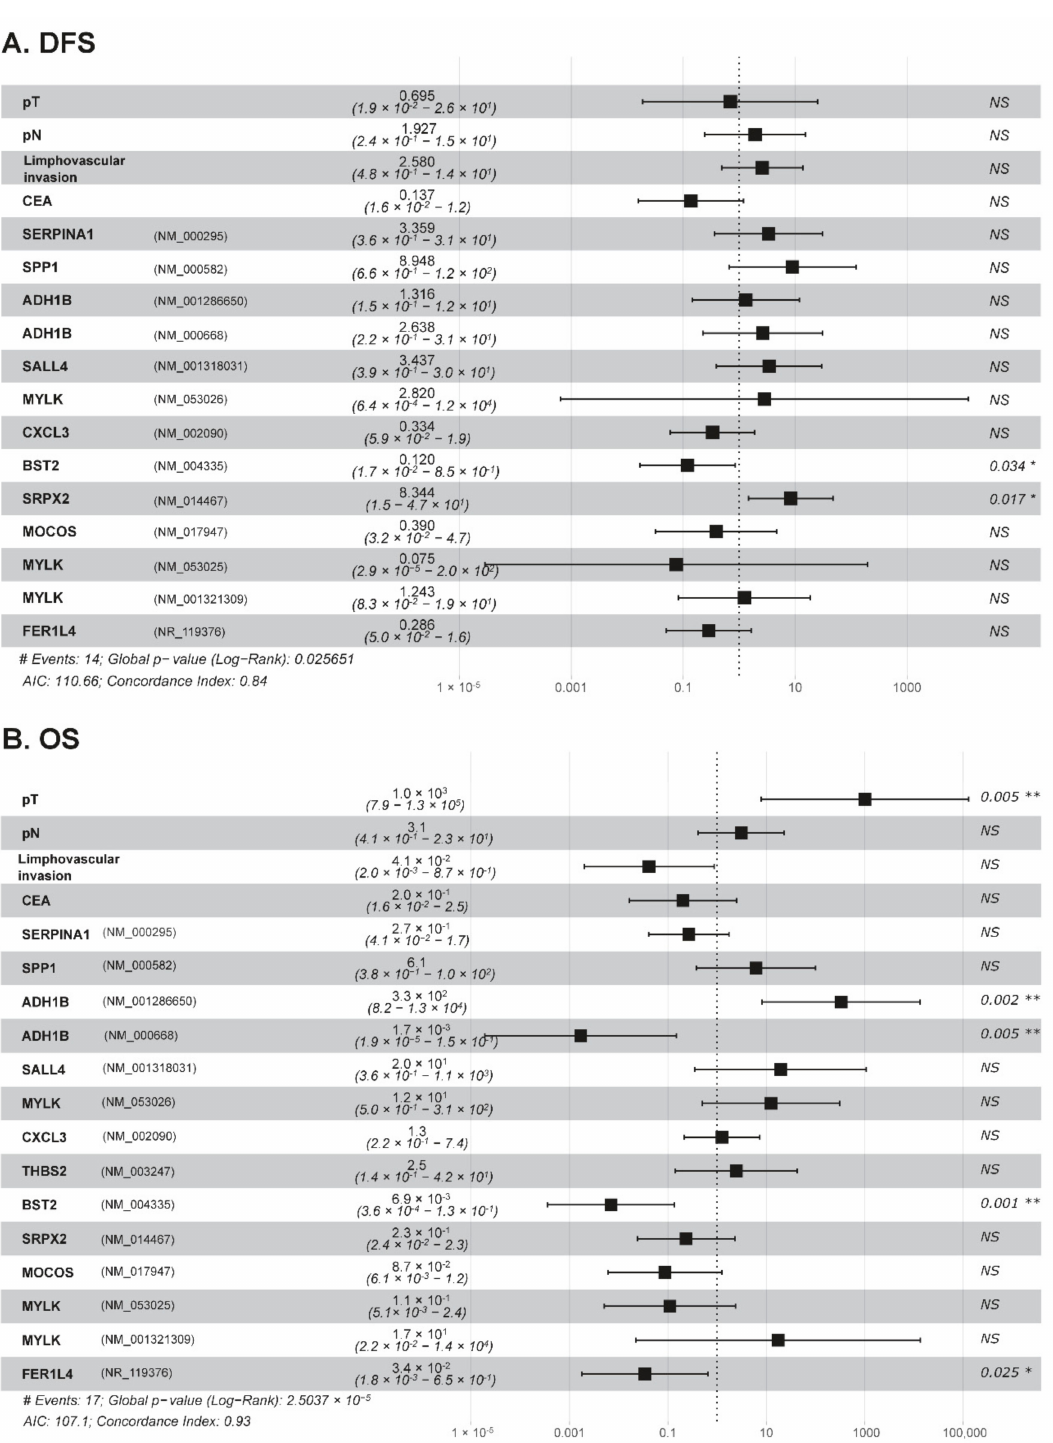
Figure 5. Multivariate analysis of prognostic impact of histological and genetic features. BST2 and SRPX2 are the only statistically significant independent predictors of disease-free survival (DFS) (panel ( A )). Histopathological tumour classification (pT), lymphovascular invasion, ADH1B gene (NM_001286650), ADH1B gene (NM_000668), BST2 gene, and FER1L4 gene also showed a prognostic impact on overall survival (OS) in the multivariate analysis (panel ( B )). Survival analysis parameters are indicated with #. CEA: Carcinoembryonic antigen. Survival information was available from 55 cases. NS: no statistically significant differences observed ( p > 0.05). Values with “*”are those that are significant below 0.05 while those marked with “**” are less than